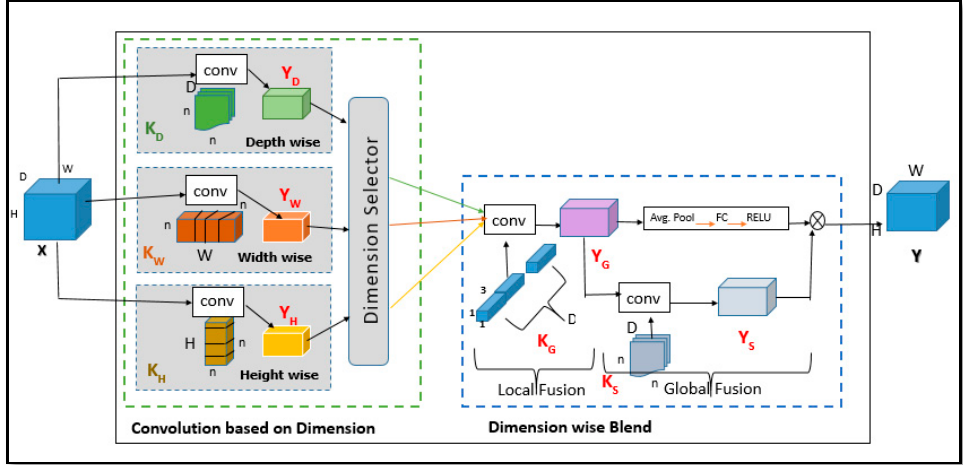
Figure 12. DBGC Figure 12. DBGC architecture.